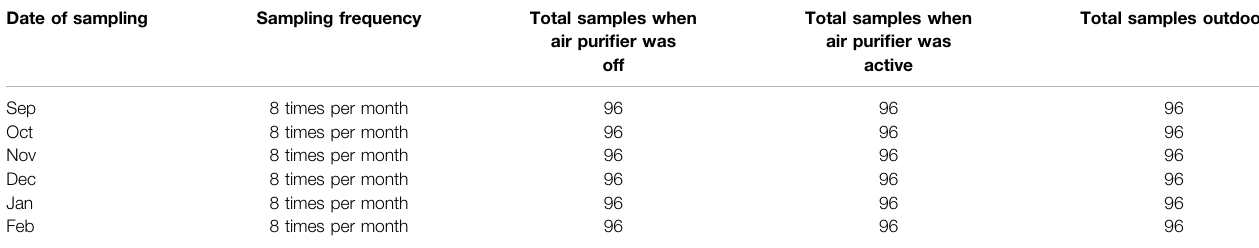
TABLE 2 | Summary of sampling details for nursery school in Gliwice